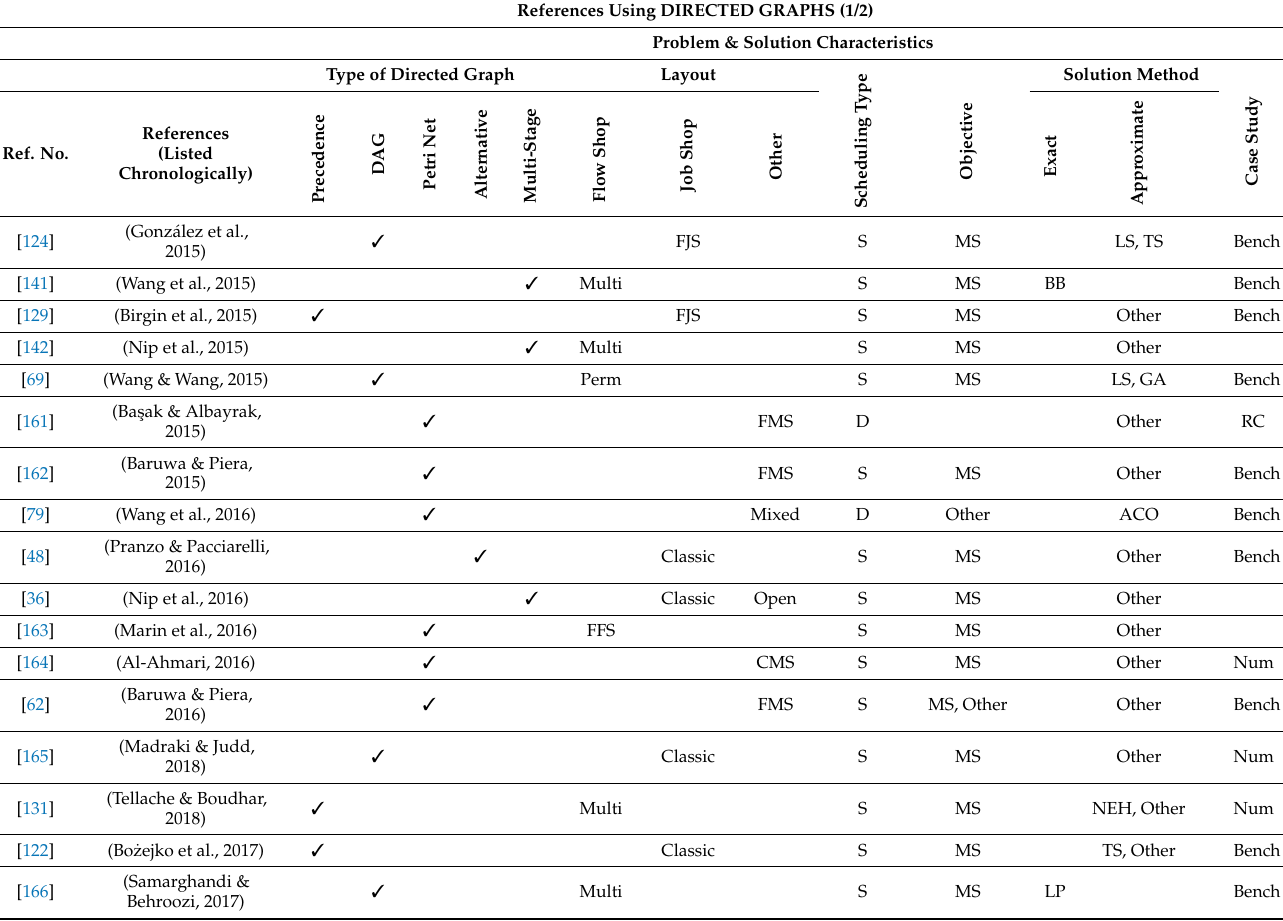
table headings. Table 6. Overview of references in the dataset using directed